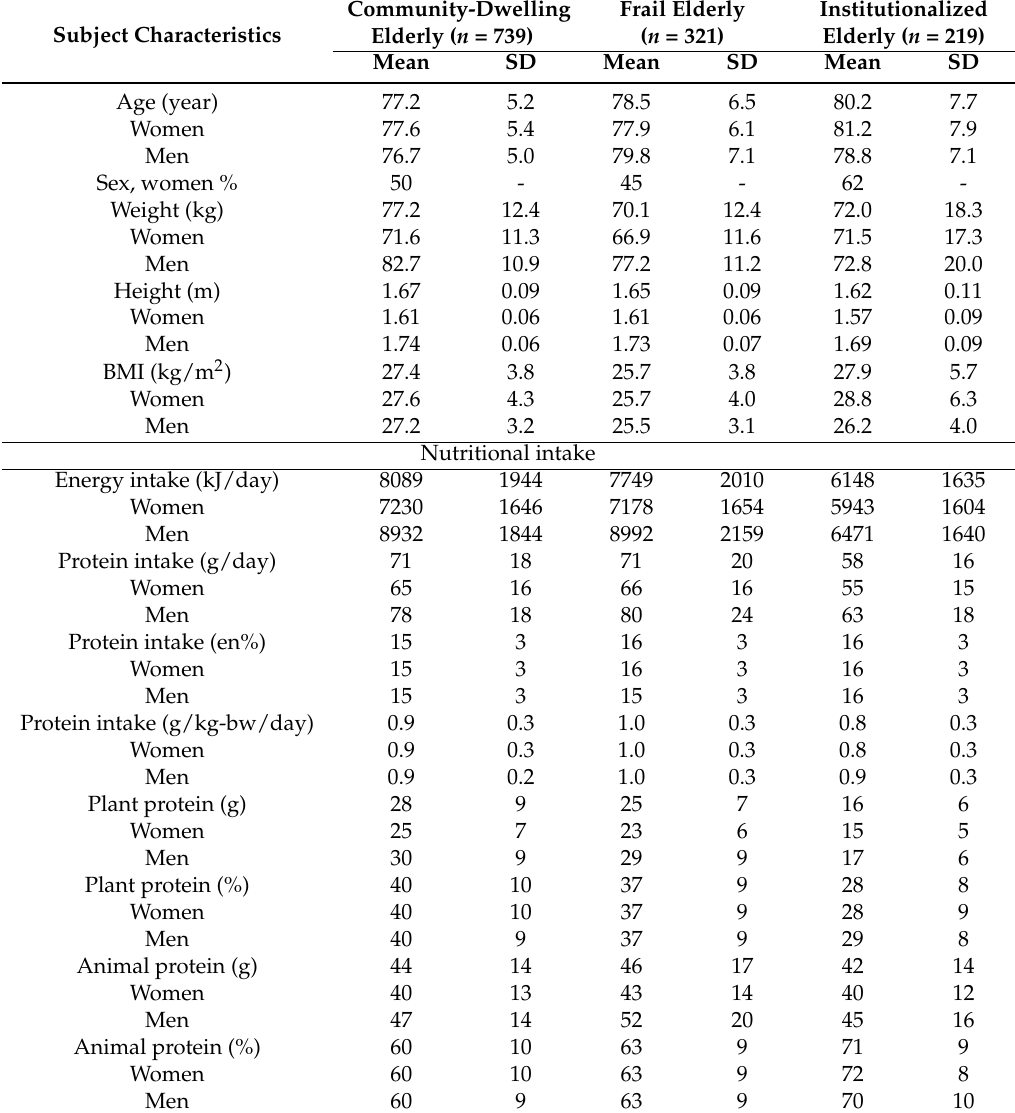
Subject characteristics and nutritional intake of community-dwelling, frail and institutionalized elderly